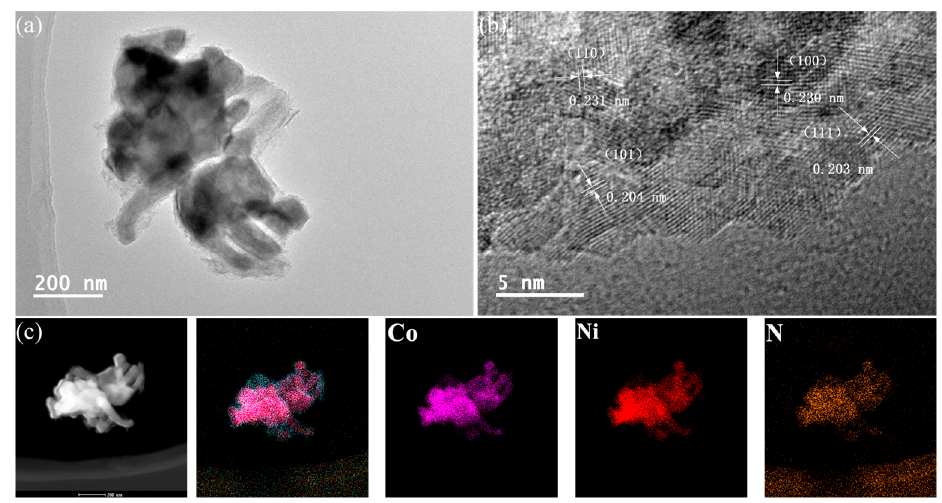
Figure 5. ( a ) TEM; ( b ) HRTEM and ( c ) elemental-mapping images of Ni 0.3 Co 0.7